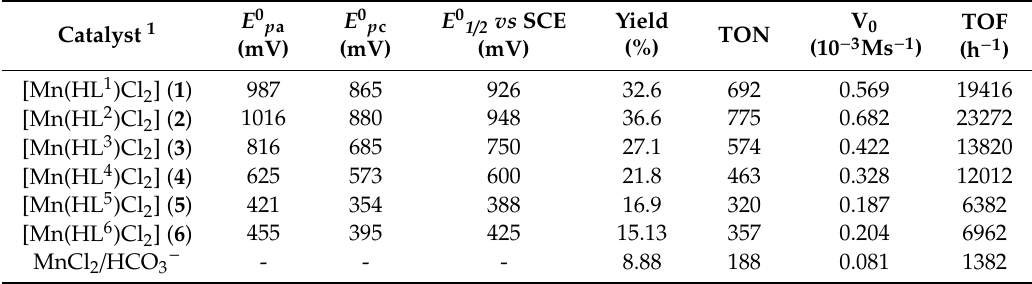
Table 2. Comparison of the catalase-like activity of [Mn II (HL n )Cl 2 ] ( 1 – 6 ) complexes in bicarbonate bu ff er (pH = 9.6; HL n = 1,3-bis(2’-Ar-imino)isoindoline, Ar = pyridyl (n = 1), 4-methylpyridyl (n = 2), imidazolyl (n = 3), thiazolyl (n = 4), benzimidazolyl (n = 5) and N -methylbenzimidazolyl (n =